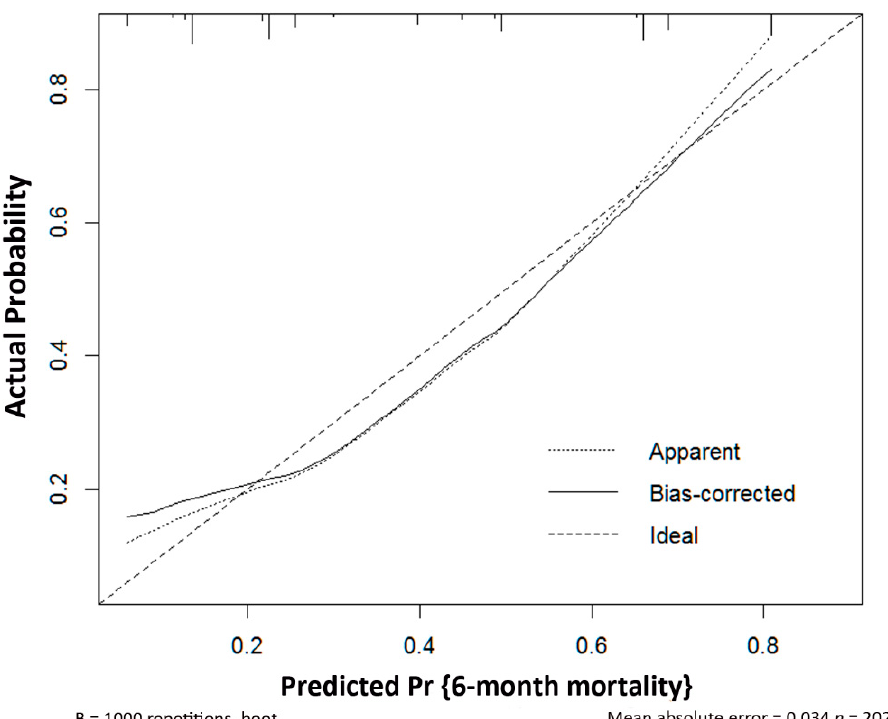
Figure 4. Calibration of the risk prediction model.